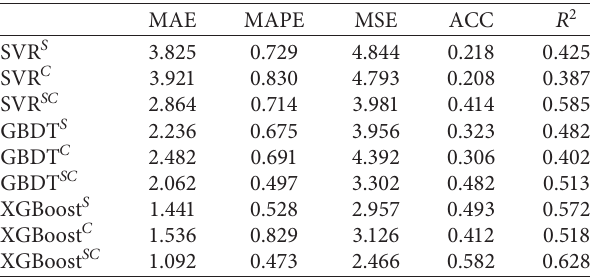
Table 6: Prediction results under 30% loss of